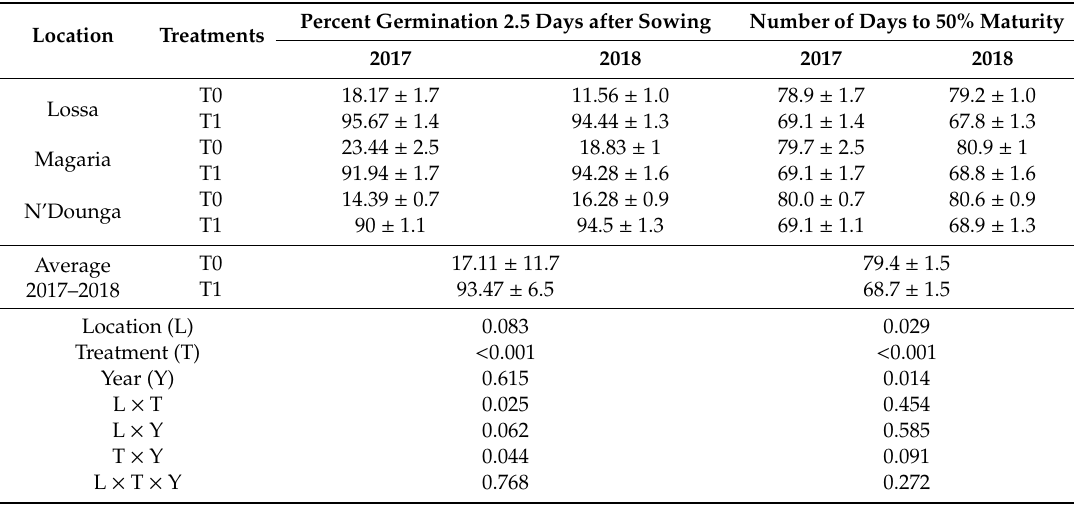
Table 2. E ff ects of treatments on percent germination 2.5 days after sowing and number of days to 50% maturity. Probabilities of main e ff ects and interactions included.